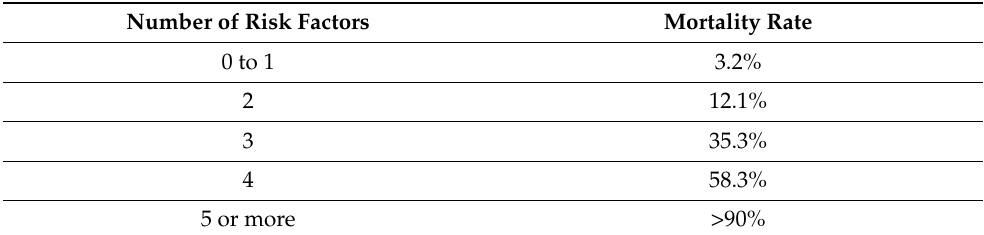
Table 1. SCORTEN score interpretation of the